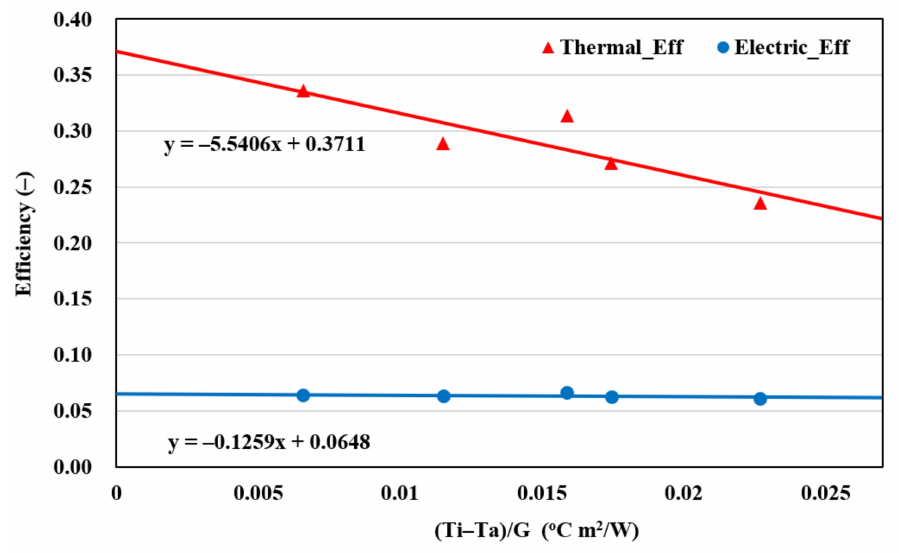
Figure 6. Thermal and electrical efficiencies of air-type PVT collector based on experiment results.